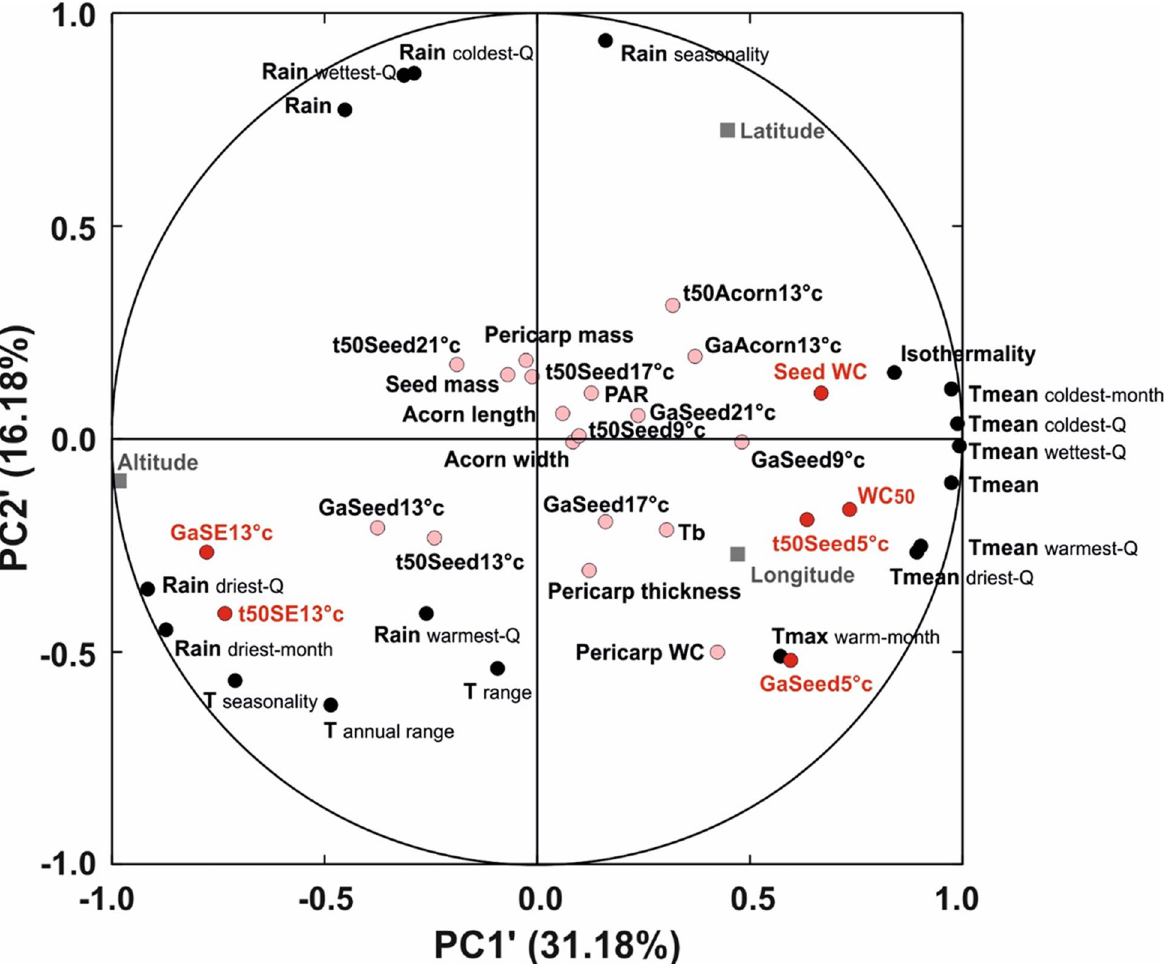
Fig. 6 Principal Component Analysis (PCA) correlations (factor loadings) of climatic variables (black circles) and seed morphophysiological traits (pink circles, red circles for correlations higher than 0.5) with the first two principal components (PC1 ′ and PC2 ′ ). Longitude, latitude and elevation, in grey, were treated as supplementary